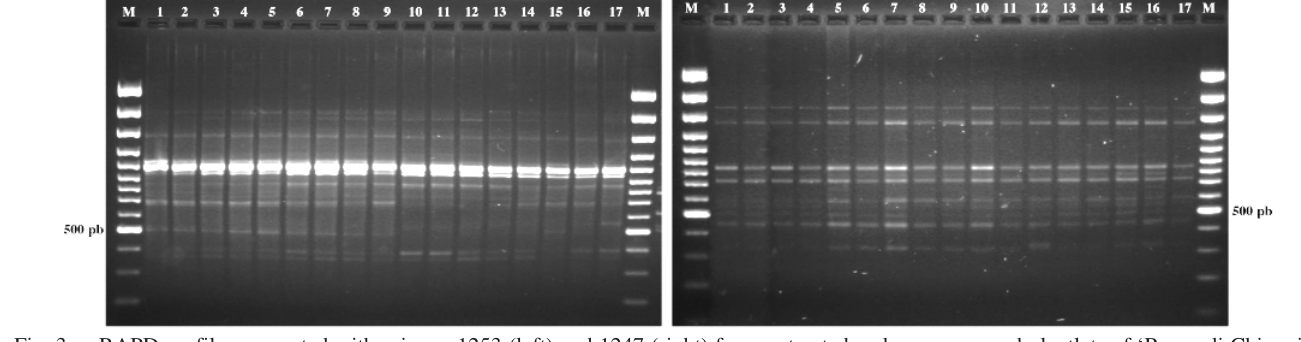
Fig. 3 - RAPD profiles generated with primers 1253 (left) and 1247 (right) from untreated and cryopreserved plantlets of ‘Rosso di Chioggia’ line. In both images, lanes M correspond to the 100-bp ladder; lanes 1-9 correspond to the amplification products from untreated sam- ples, lanes 10-17 correspond to the amplification products from cryopreserved